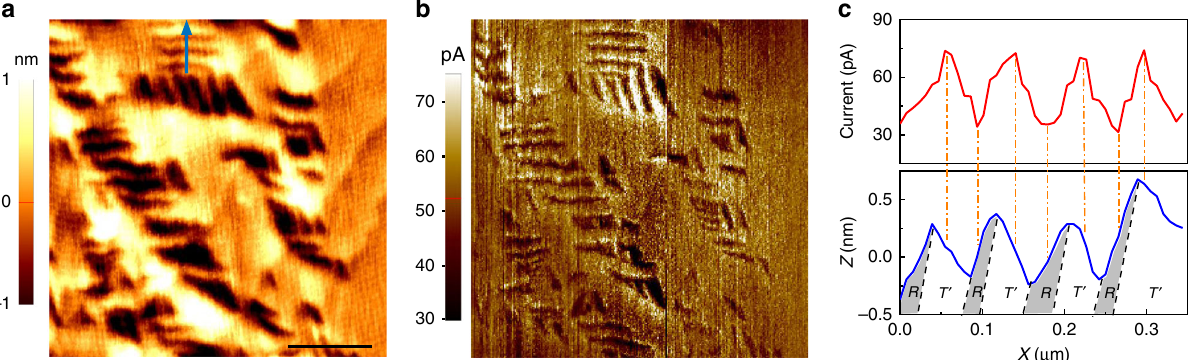
Fig. 1 Spatially resolved dark current distribution. a Surface topography and b corresponding dark current distribution mapped on the BiFeO 3 (60 nm)/ La 0.7 Sr 0.3 MnO 3 (5 nm)/LaAlO 3 fi lm without any illumination. Scale bar 500 nm. c Dark current and surface morphology pro fi le comparison of the area marked by blue arrow in ( a ). The current is acquired by applying 2 V to the bottom electrode with the conductive tip virtually